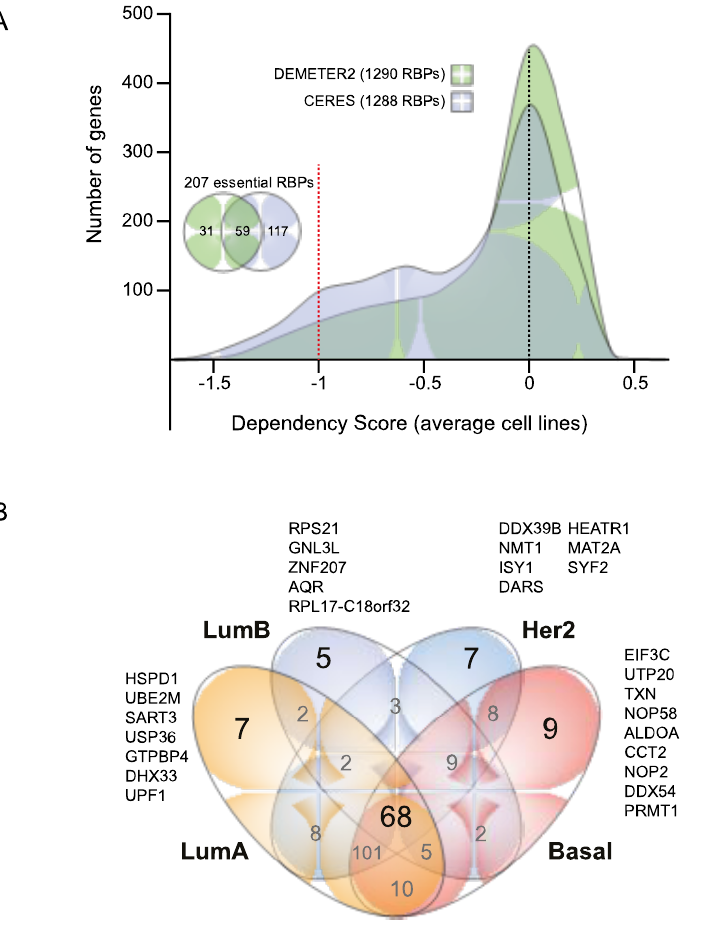
Figure 6. RBPs BC dependencies. ( A ) The distribution of dependency scores of 1290 (DEMETER2) and 1288 RBPs (CERES) is shown. ( B ) A Venn diagram comparing BC essential RBPs per subtype is presented.